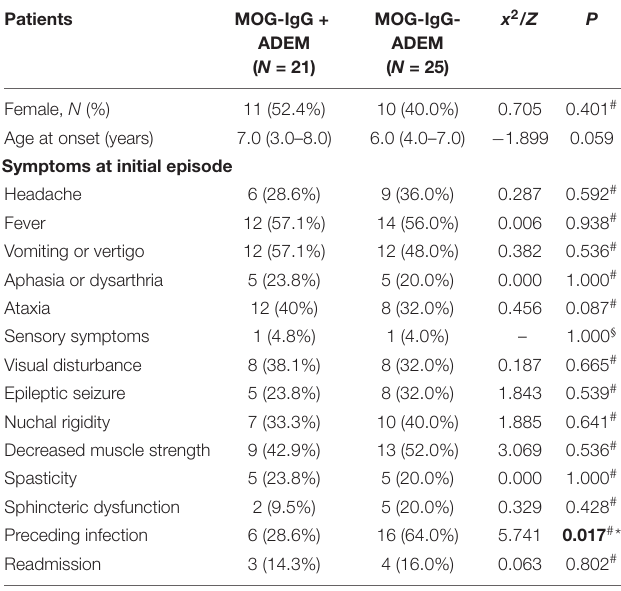
TABLE 1 | Demographic, clinical, and cerebrospinal fluid (CSF) features of ADEM children with or without myelin oligodendrocyte glycoprotein-immunoglobulin G (MOG-IgG).